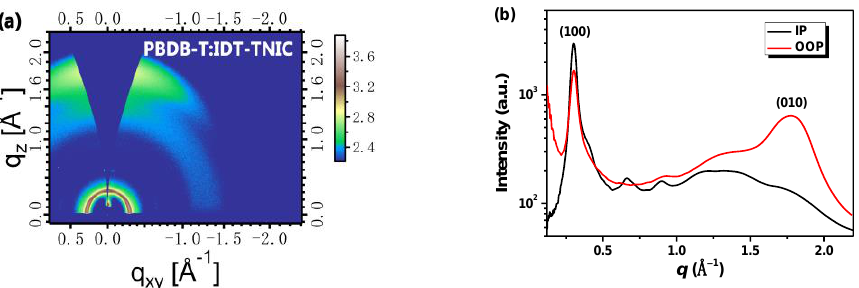
Figure 6. The two-dimensional GIWAXS patterns of PBDB-T:IDT-TNIC blend film ( a ) and the corresponding in-plane and out-of-plane profiles ( b ) under optimal condition.